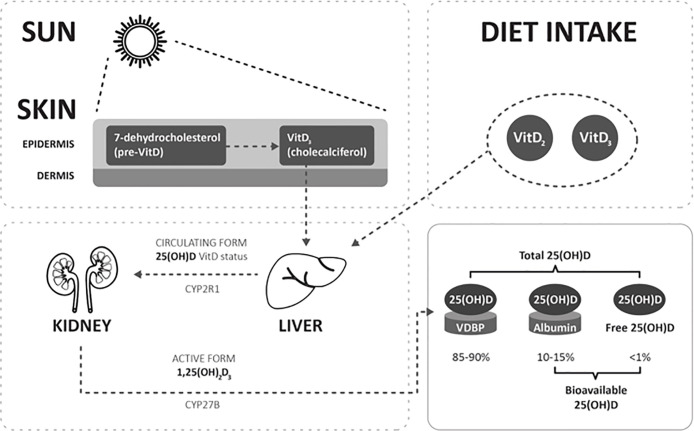
Simple schematic diagram depicting Vit D metabolism and the different Vit D metabolites: 25(OH)D, bioavailable 25(OH)D, and free 25(OH)D. VDBP, vitamin D binding protein; hepatic 25-hydroxylase, CYP2R1; renal 1α-hydroxylase, CYP27B1.